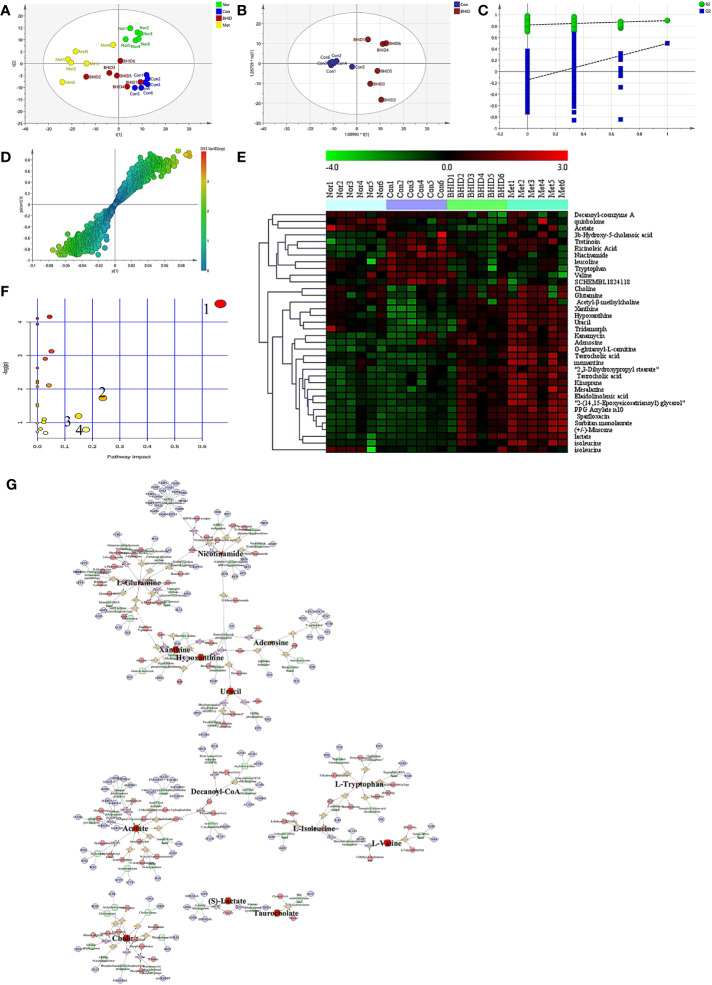
Differential metabolite analysis of serum. The principle component analysis (PCA) analysis in different groups (A) and orthogonal projection to latent structure-discriminant analysis (OPLS-DA) analysis between control and Bekhogainsam decoction (BHID)–treatment group (B). The permutation test of the OPLS-DA mode between the control and BHID groups (C) and the S-plot analysis (D). The heat map of potential metabolites (E) and the summary of pathway analysis of differential metabolites (F): valine, leucine, and isoleucine biosynthesis (1); nicotinate and nicotinamide metabolism (2); tryptophan metabolism (3); and alanine, aspartate, and glutamate metabolism (4). Metabolite-reaction–enzyme-gene graph (G). The hub metabolites are presented in bold font. Nor, normal group; Con, streptozotocin (STZ)–induced DN control group; BHID, BHID 500 mg/kg group; and Met, metformin 250 mg/kg group.